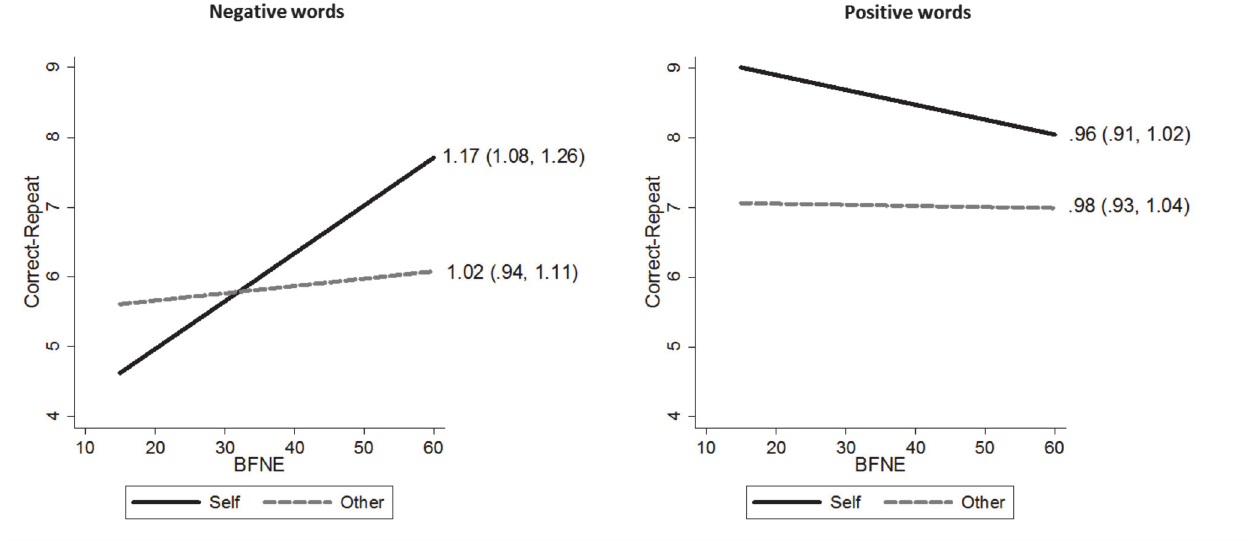
Fig 4. Correct-repeat behaviour during the learning phase. Predicted values from the Poisson regression models testing for the referential-condition by FNE interaction on correct-repeat behaviour during the learning phase in separate models for negative (left) and positive (right) words. We used the lincom command in Stata to estimate the relationship (rate ratio and 95% confidence intervals) between correct-repeat behaviour and a one standard deviation increase in BFNE (1 s.d. corresponds to 11.5 BFNE points) by referential condition. FNE was selectively associated with self-referential negative-correct- repeat responses, with the coefficient indicating a 17% increase for each 11.5 point increase in BFNE, p < 0.001. There was no evidence to suggest that negative-correct-repeat behaviour in the other other-referential condition, or that positive-correct-repeat behaviour in either condition, varied with FNE, p ’ s >